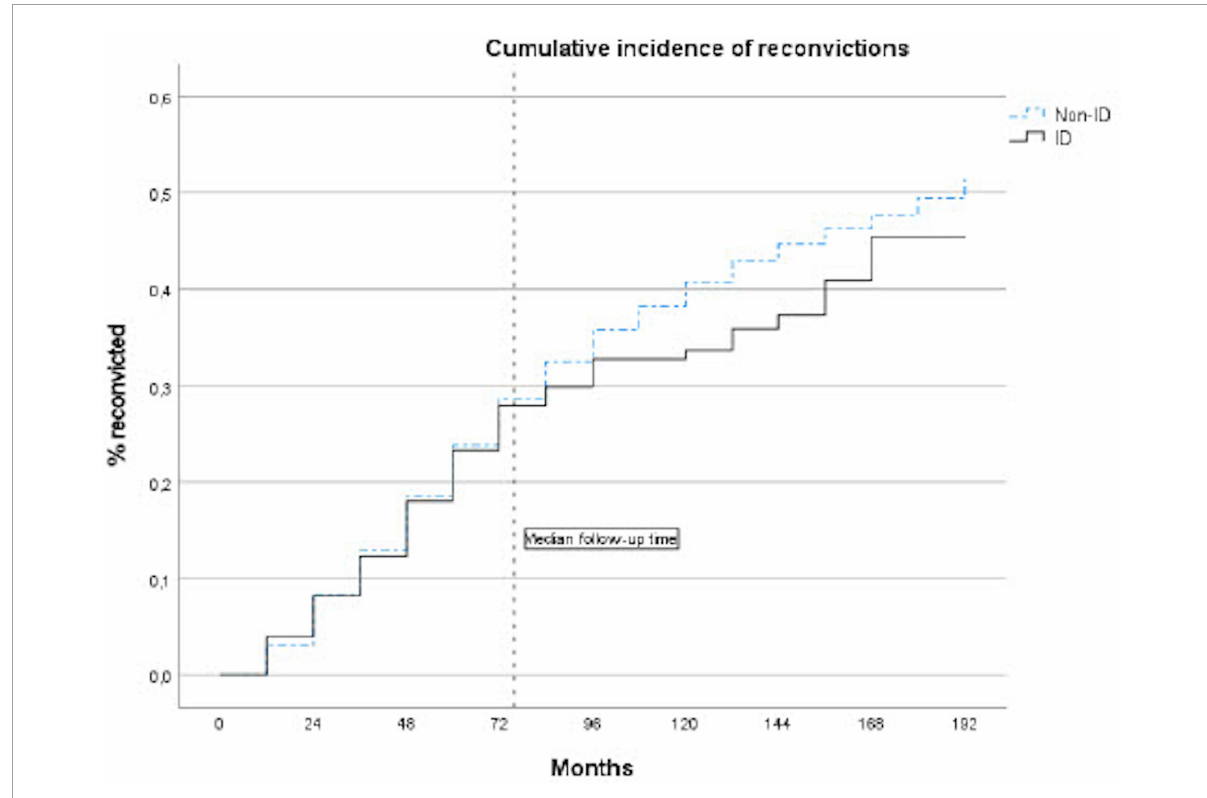
FIGURE1 Cumulative incidence of reconvictions, comparing ID and non-ID offenders sentenced to forensic psychiatric care.